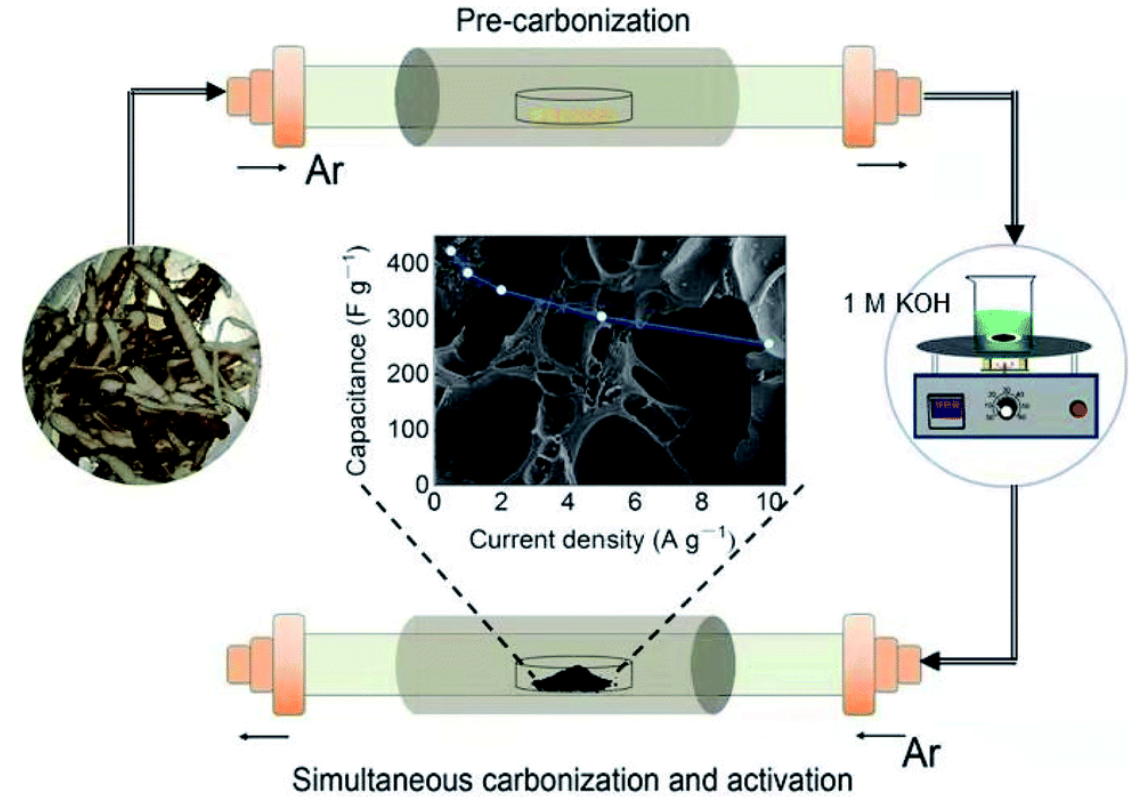
Figure 12. Schematic illustration of YPC derived from yam waste. Adapted from reference [85]. This